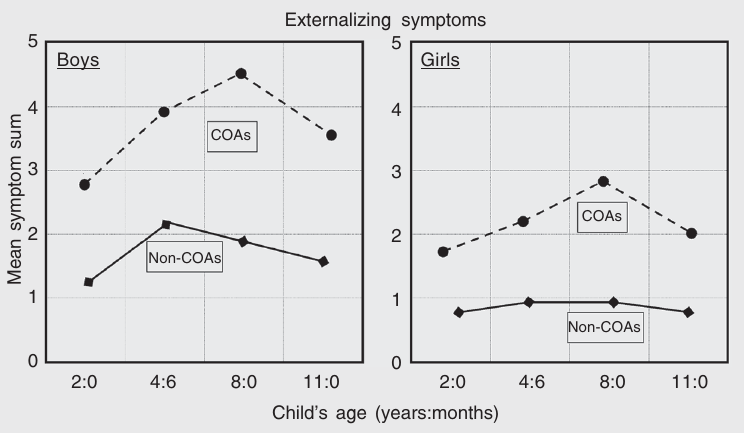
Figure 2. Longitudinal effect of paternal alcoholism on the development of externalizing symptoms in males and females. COAs = children of alcoholic fathers; non-COAs = children of non-alcoholic fathers.